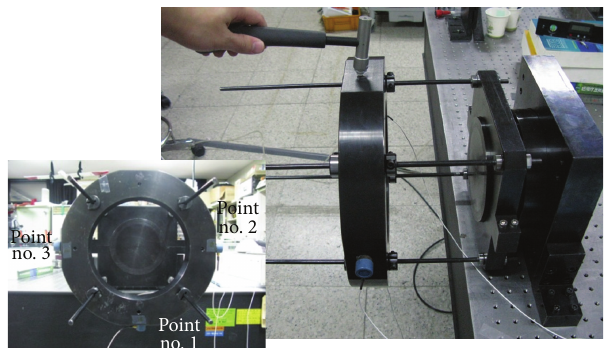
Figure 10: Experimental setup of